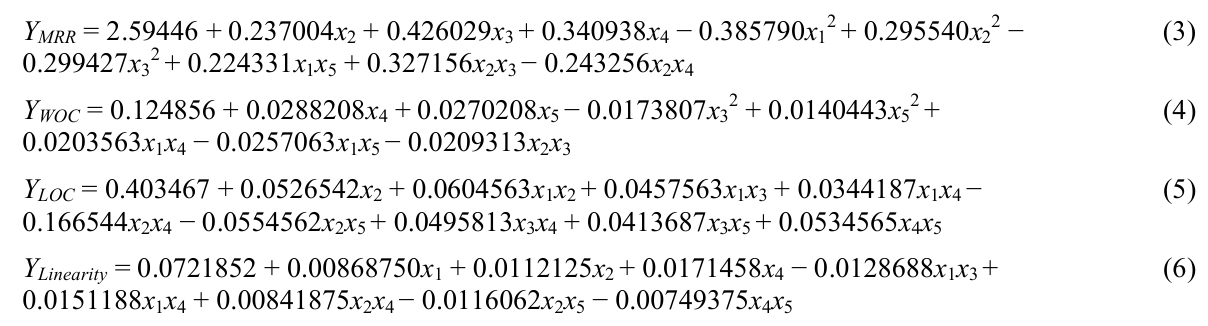
EMM process parameters along with their levels (Malapati and Bhattacharyya, 2011) Parameter Unit Levels Pulse frequency ( x ) 1 Machining voltage ( x 2 ) Electrolyte concentration ( x 4 ) g/l 50 Micro-tool feed rate ( x ) 5